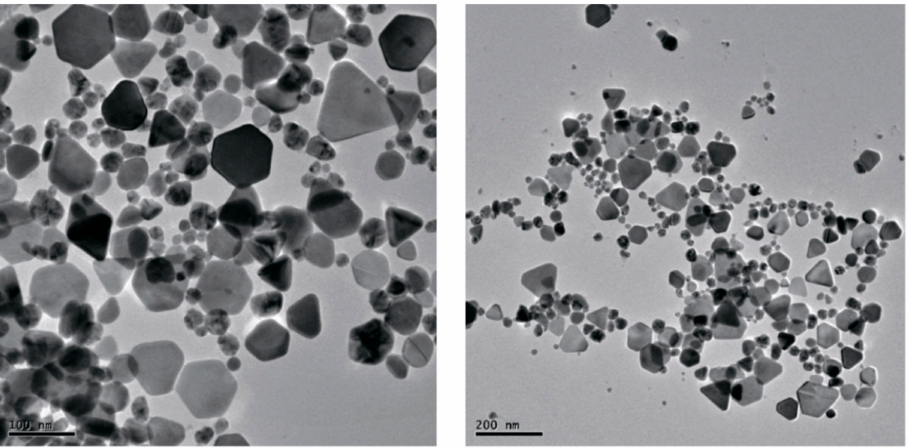
Figure 8. Transmission electron microscope (TEM) image of Ag-NP having various shapes and obtained in [186]. At a scale of 100 nm ( left ) and at a scale 200 nm ( right )